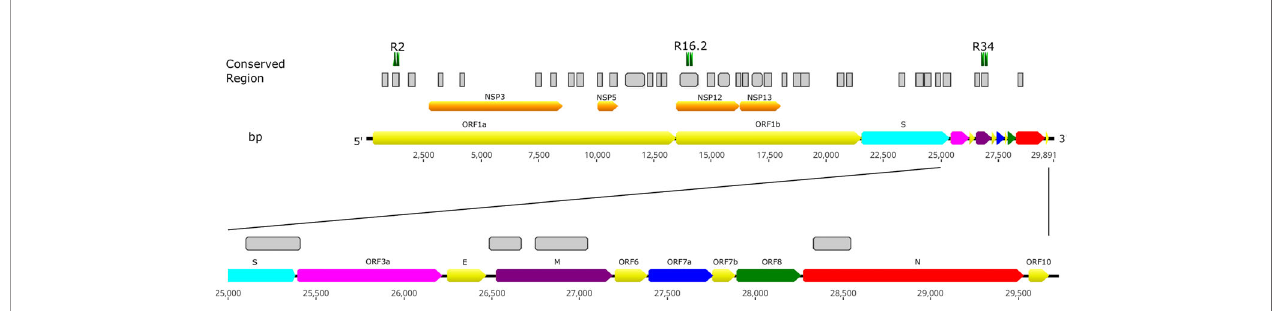
FIGURE 1 | Locations of conserved regions that are potential diagnostic targets, identi fi ed by SARS-CoV-2 genome-wide comparison. LAMP primer sets designed for regions R2, R16.2, and R34 were combined in the multiplex RT-LAMP assay and resulted in sensitive and speci fi c detection of SARS-CoV-2. Bp, base